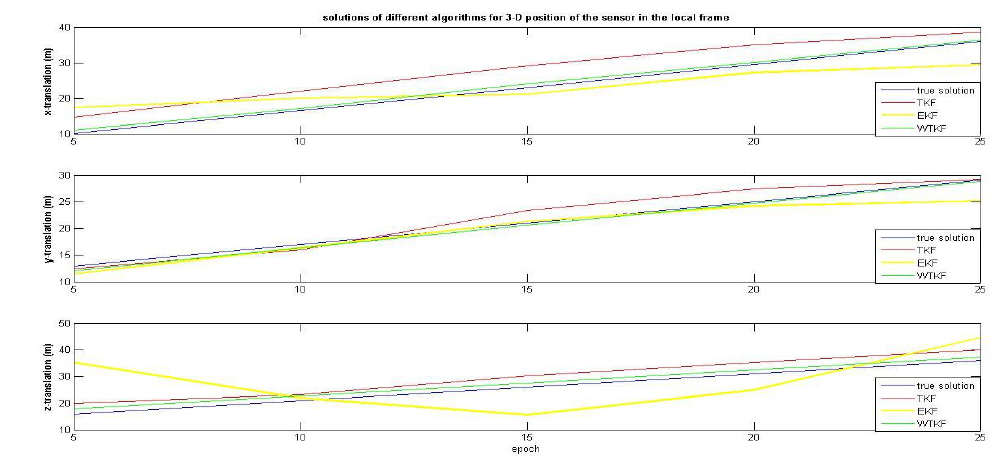
Figure 4-a: the solution of different algorithms for 3-D position of the sensor in a local frame